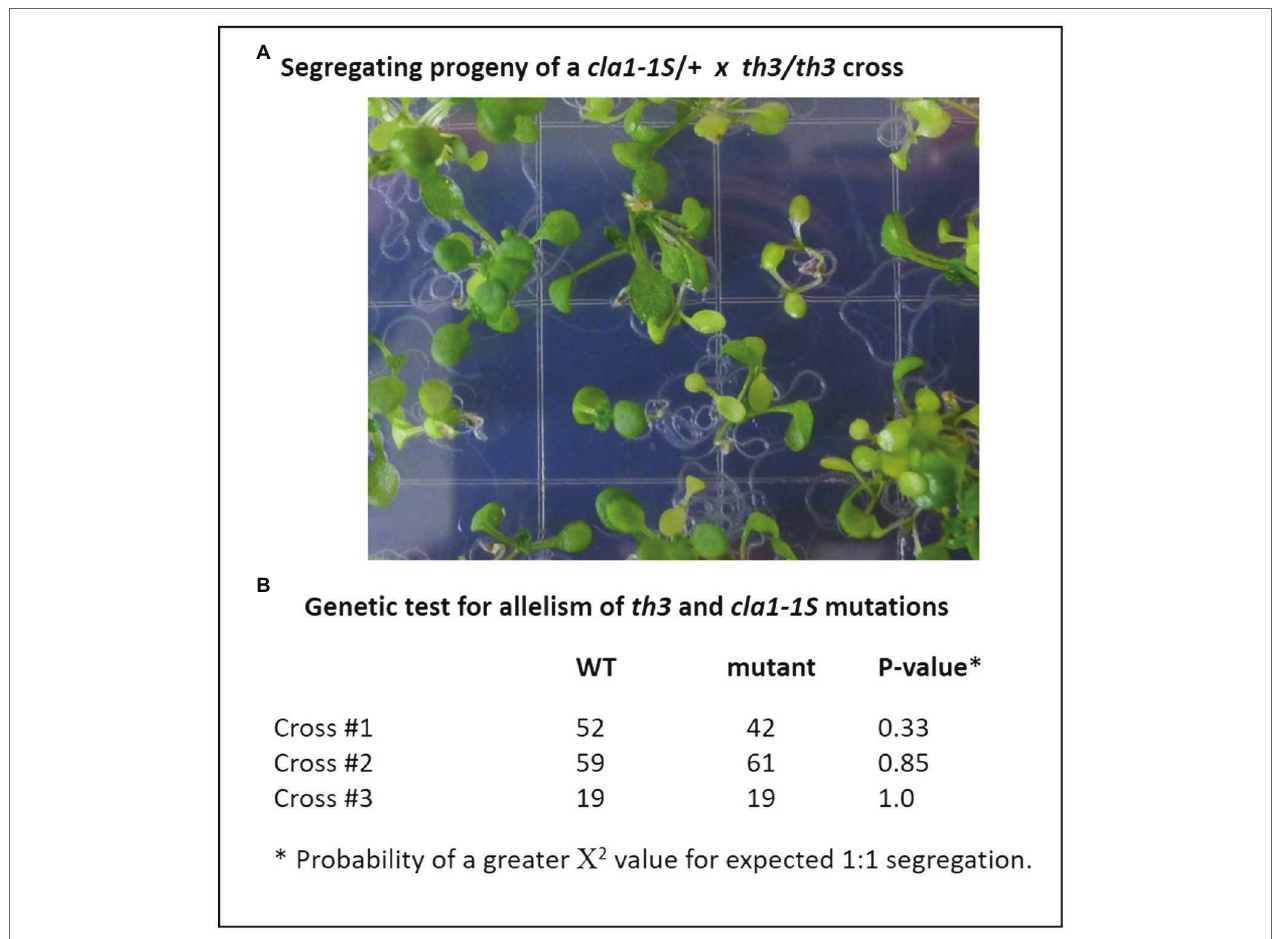
FIGURE 3 | The th3 mutation is an allele of the DXS1 ( cla1 ) gene. Genetic complementation was tested by crossing th3 homozygous plants with plants heterozygous for the cla1-1S reference allele. (A) Segregation of pale-green plants in F1 progeny. Seeds were planted on MS media and seedlings were imaged at 7 days after sowing. (B) Expected 1:1 segregation ratios indicative of non-complementation were observed in progeny of three independent crosses. Fit to an expected 1:1 segregation ratio was tested using χ 2